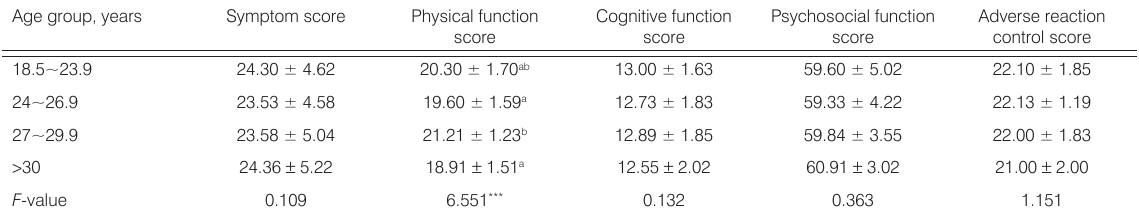
Table 3. Comparison of quality-of-life scores of patients with different BMI values in the experimental group after 3 wk ( ± ) x s .